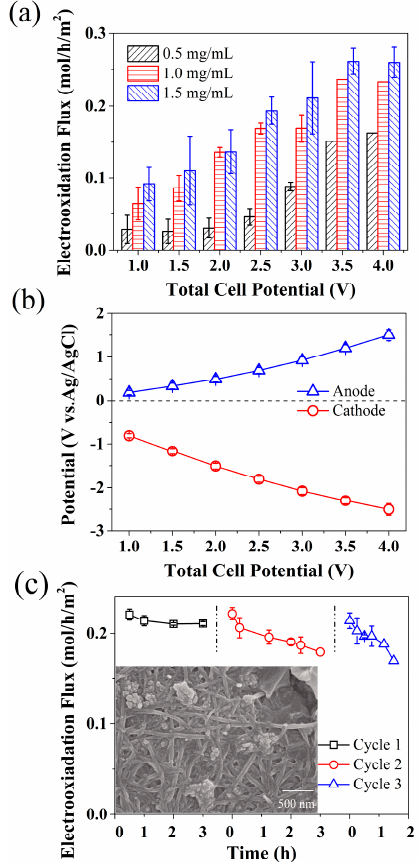
Figure 3. MO electrooxidation flux ( a ) and open ‐ circuit potential ( b ) as a functional total cell potential. Experimental conditions: [MO] in = 0.06 mmol/L, [Na 2 SO 4 ] = 10 mmol/L, [CNT] ink = 1.5 mg/mL,